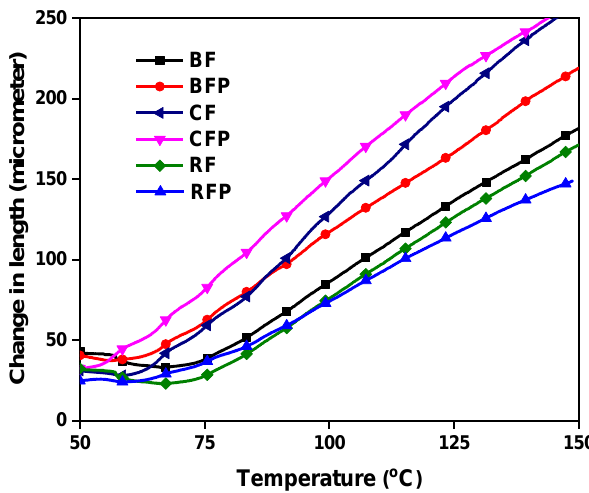
Figure 7. Thermal expansion behavior of the composites.